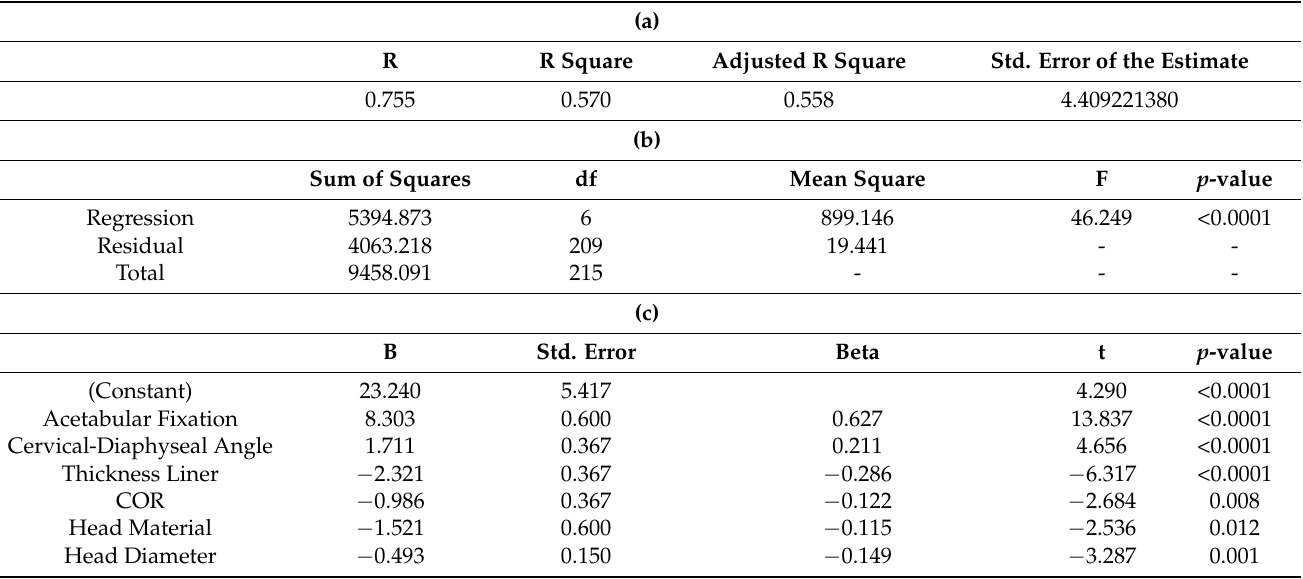
Table 3. ( a ) Statistical summary for VM Stress variable dependent. ( b ) ANOVA Analyses for VM Stress dependent variable (MPa). ( c ) Statistical coefficients for VM Stress dependent